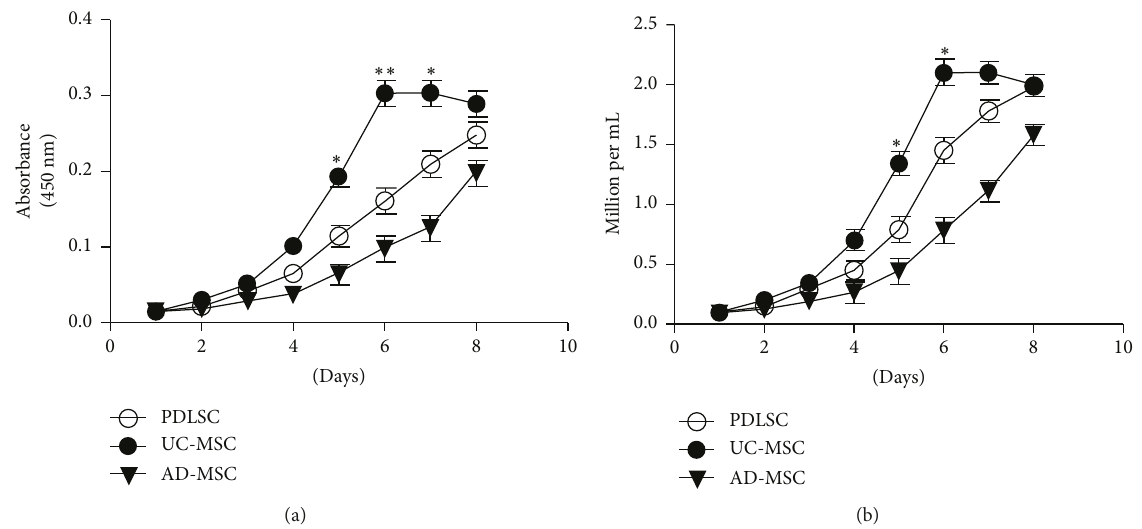
Figure 2: PDLSC, UC-MSC, and AD-MSC growth curves. Naive MSCs were seeded at 1 × 10 4 /well in a 24-well plate and cultured. The number of cells was counted every other day using the (a) Cell Counting Kit-8 (CCK-8) assay or (b) TC10 automated cell counter. The experiment was performed independently at least three times, and representative fi gures are shown. p values were obtained by ANOVA followed by Tukey ’ s post hoc test. ∗ p < 0 05 and ∗∗ p < 0 001 .